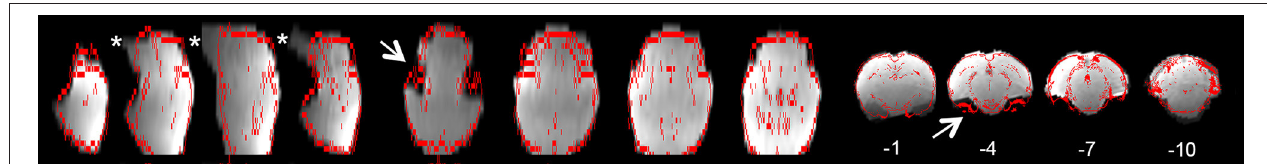
FIGURE 2 | Representative registration of 2-week-old rat using an adult rat template. Figure illustrates representative individual functional-to-standard registration of all 2-week-old rats included in the ICA analysis. The gray image represents individual rs-fMRI data while the red contour represents the outline of an adult atlas as reported by FSL output. First four columns are in axial view; the next four in sagittal, and the remaining four columns represent coronal view. Common expected artifact is seen in the ventral regions of the rat brain (near ear channels; Schwarz et al., 2006). It is best visualized in the first transverse and the second coronal section (arrows). Distortions noted in ventral parts of the brain were noted in all individual rats only in the caudal region of the brainstem (stars). Numbers below coronal slices represent distance from Bregma (mm). Section with Bregma of 0mm corresponds to Panel 17 of Rat Brain Atlas (Paxinos and Watson, 1998). Left hemisphere of the brain corresponds to the right side of the